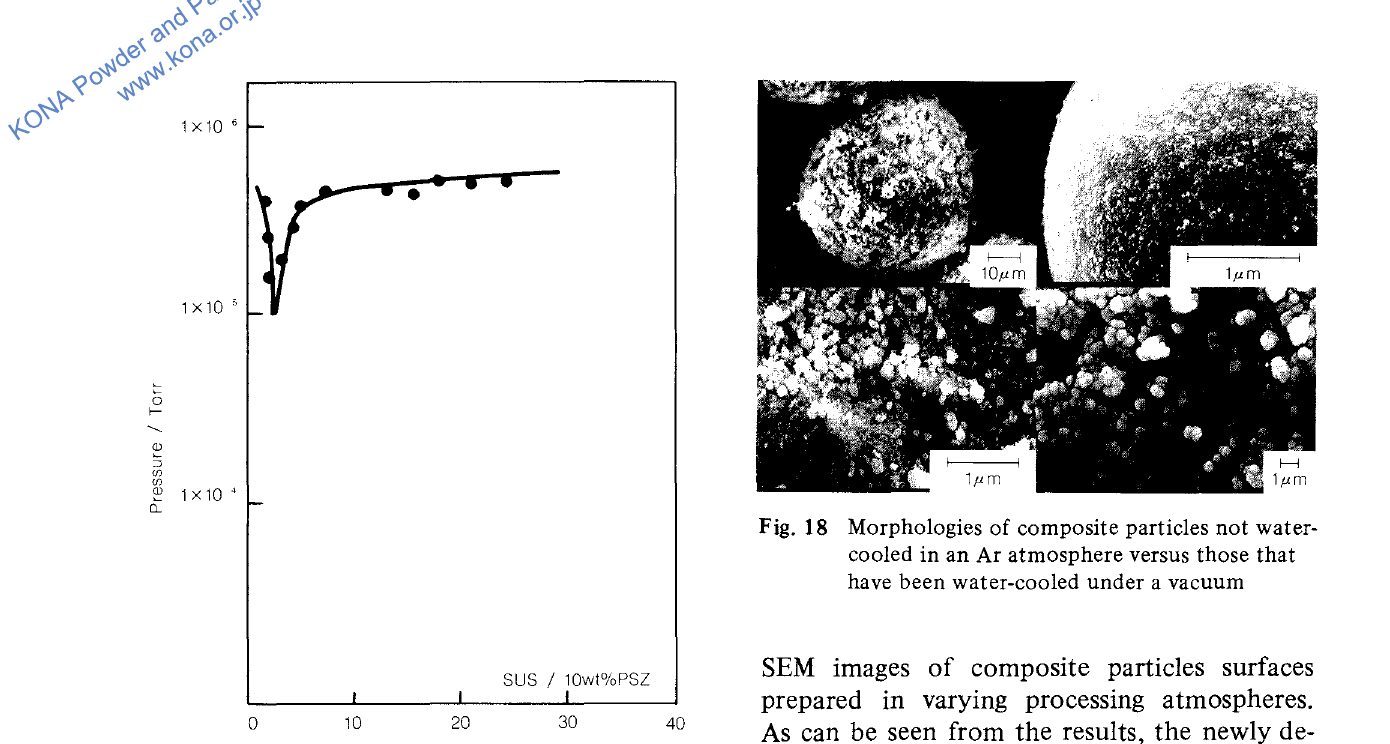
Fig. 17 Desorption of the absorbed gases during mechanofusion